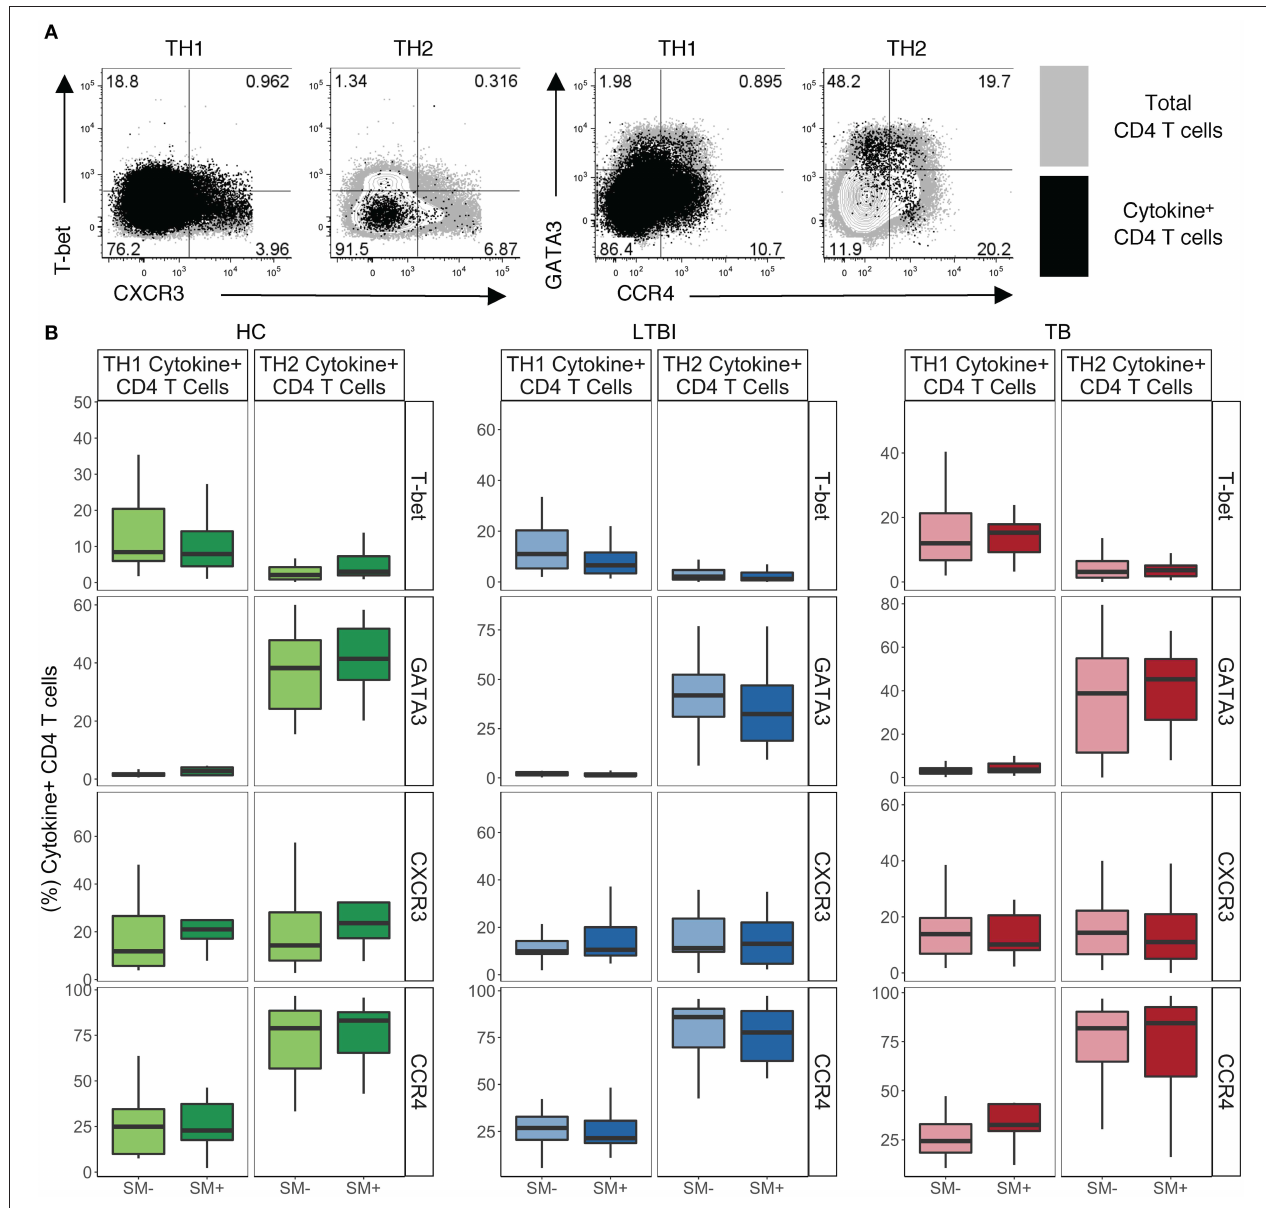
FIGURE 3 | TH1 cytokine + cells express low levels of TH1 lineage markers while TH2 cytokine + CD4T cells express high levels of TH2 lineage markers independent of SM and TB infection status. PBMC samples obtained from individuals in each of six groups defined by Mtb and SM infection were incubated for 18h in media alone (negative control) or stimulated with PMA and ionomycin. Intracellular expression of IFN- γ , TNF- α , IL-4, and IL-13 was evaluated by flow cytometry and cytokine + cells were aggregated by functional T cell lineage ( Figure S2 ). Samples meeting the criteria for a positive response (see Materials and Methods) were evaluated for expression of lineage specific transcription factors and chemokine receptors by flow cytometry. (A) Representative flow cytometry data from an SM − HC. Plots show either TH1 cytokine + or TH2 cytokine + live CD3 + CD4 + CD8 − lymphocytes in black dots overlaying total live CD3 + CD4 + lymphocytes in gray. (B) Frequency of indicated transcription factor + and chemokine receptor + amongst TH1 cytokine + or TH2 cytokine + CD4T cells in HC (SM − , n = 24; SM + , n = 13), LTBI (SM − , n = 25; SM + , n = 25), and TB (SM − , n = 25; SM + , n = 14). Boxes represent the median and interquartile ranges; whiskers represent the 1.5*IQR. Differences in the frequency of each lineage marker + CD4T cell population between SM + and SM − individuals were assessed using a Mann Whitney U